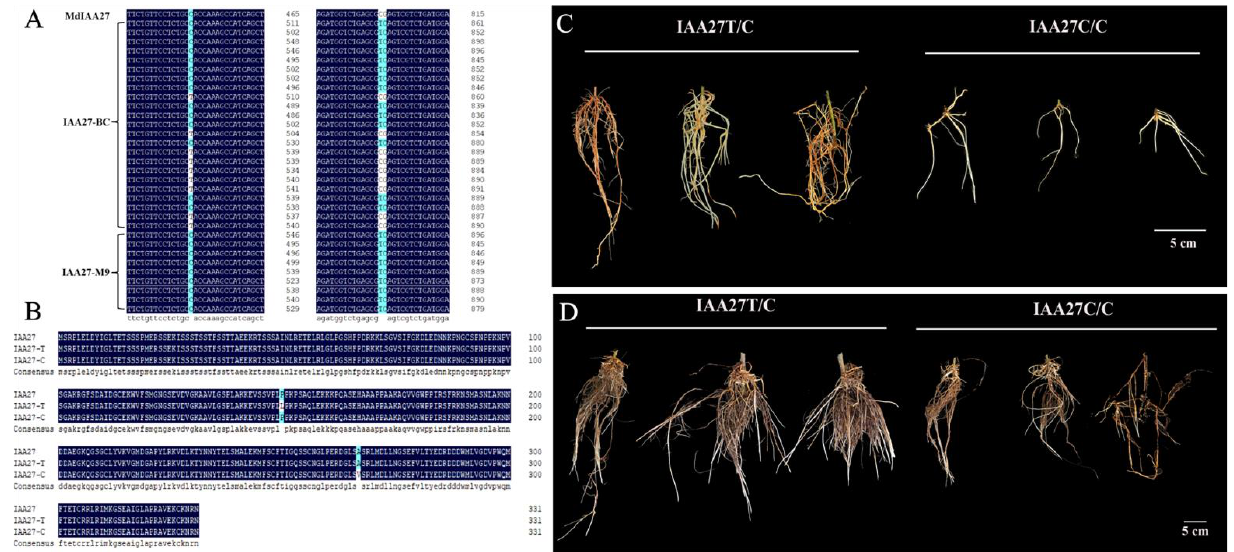
Figure 1. Identification of IAA27 related to root development in the parents ‘BC’ and ‘M9’ and their progenies. ( A ) Variation in the IAA27 CDS sequence of the parents ‘BC’ and ‘M9’. ( B ) Amino acid sequence analysis of IAA27 transcription factors. ( C ) Phenotypes of adventitious roots from six progenies crossed from ‘BC’ and ‘M9’. The progenies were harvested for adventitious root trait analysis at 30 days after cutting. Scale bars: 5 cm. ( D ) After low phosphorus treatment for 30 days, adventitious roots of progenies were photographed. Scale bars: 5 cm.